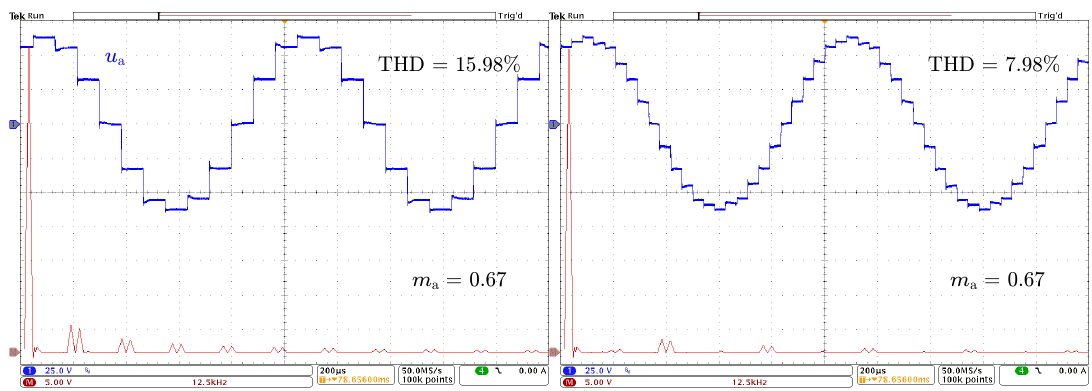
Figure 16. Output voltages and their spectra for the modular VSI with two-level ( left ) and three-level ( right ) modules.